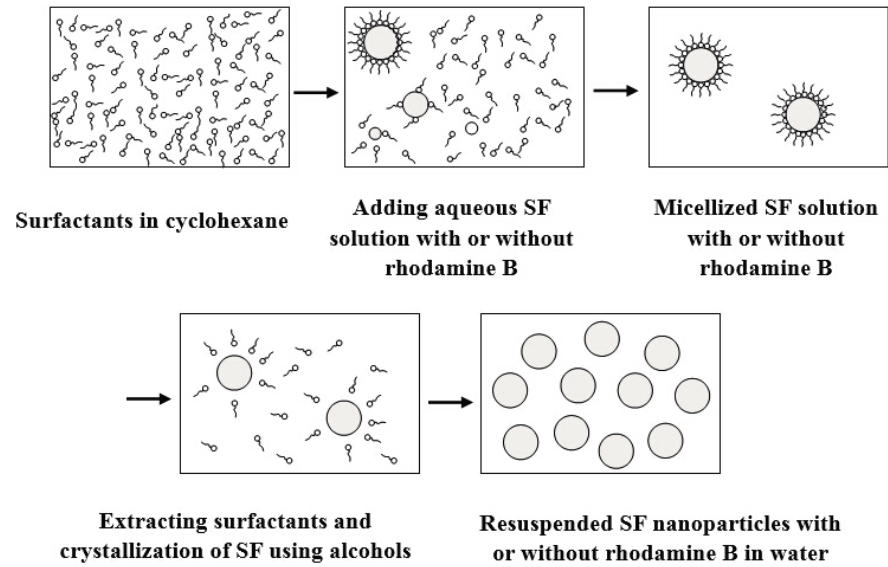
Figure 6. Schematic diagram of the microemulsion method for preparing SF nanoparticles. Adapted with permission from [41]. Copyright 2008